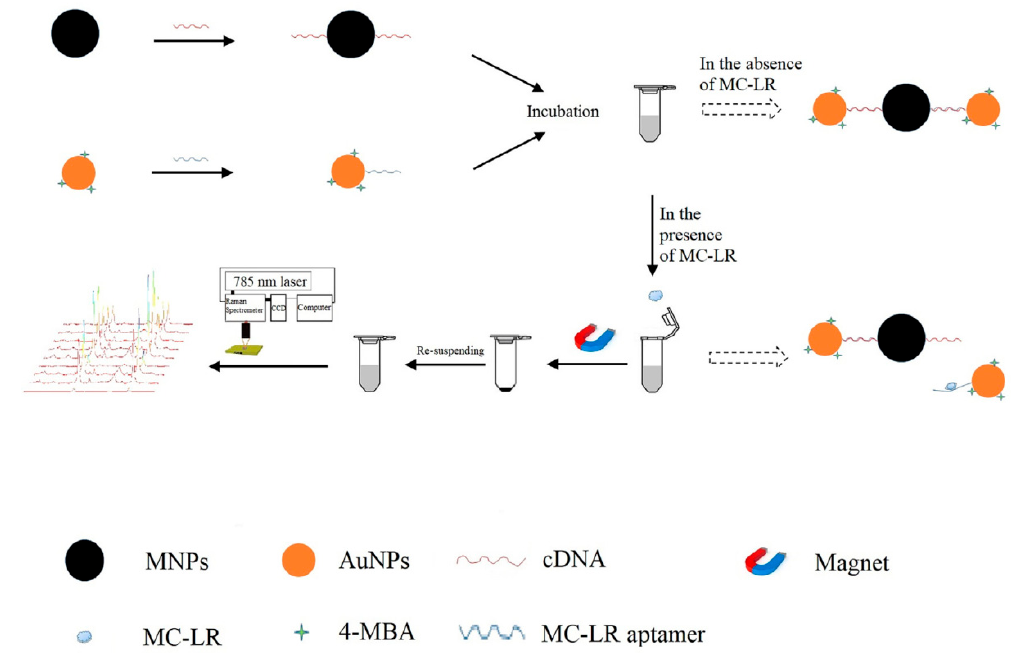
Figure 10. The principle of the analysis of MC-LR based on the SERS-based aptasensor. (Reprinted with permission from Elsevier, 2019 [75]).